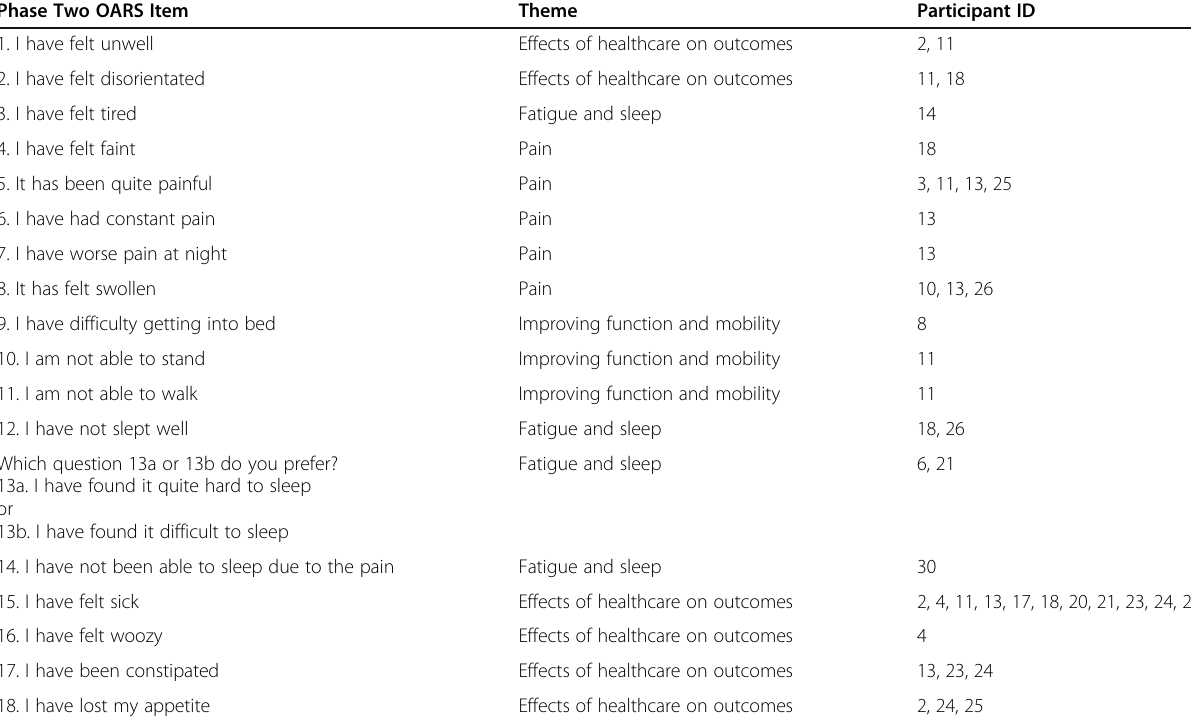
Table 4 Pilot OARS items and themes breakdowns Phase Two OARS